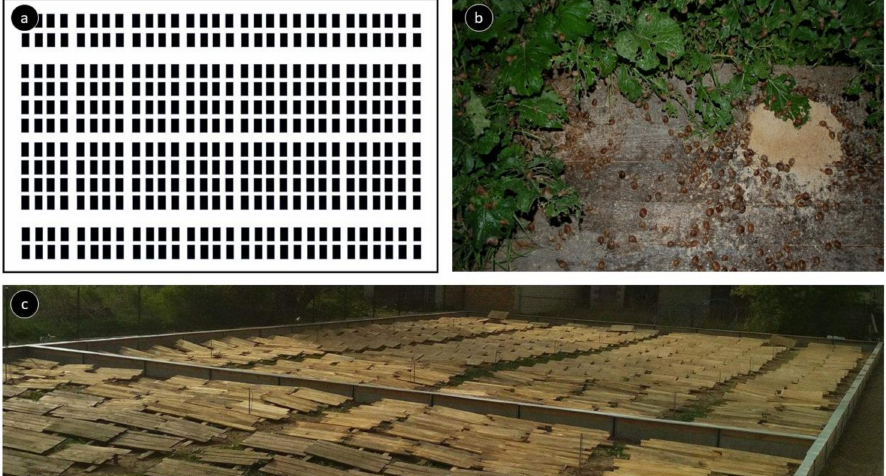
Figure 1. Feed tables: ( a ) visualisation of one plot, ( b ) snails with feed (mixture on the table and Brassica rapa growing around), ( c ) plots with tables in the experimental